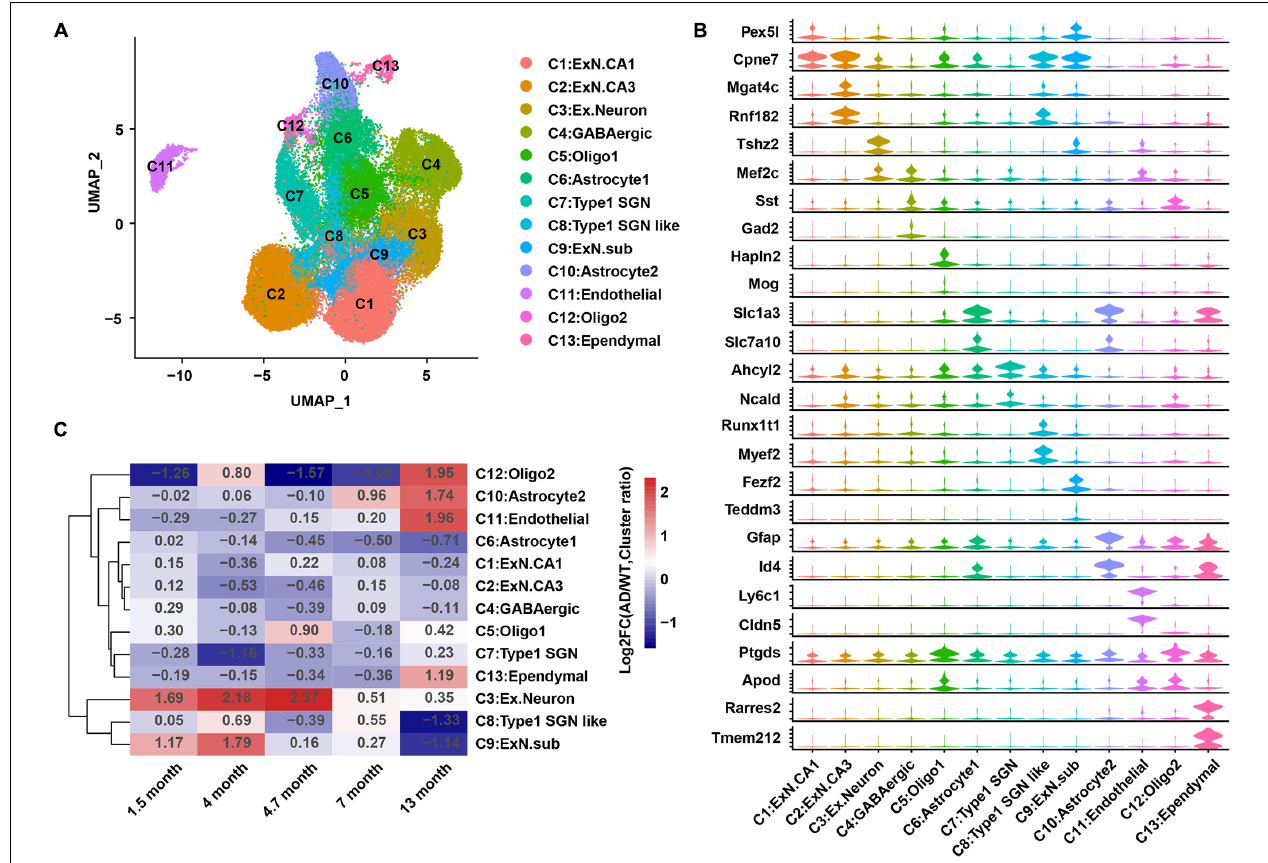
FIGURE 1 | A cell atlas of hippocampal cells in 5XFAD (AD) mice and WT mice. (A) Cell map of mouse hippocampus. Each dot represents a cell and is colored according to a cluster. (B) Violin plots showing the distribution of the expression of specific marker genes in each cell group. (C) Heatmap showing the changes in relative abundance of the 13 cell groups in AD mice compared to that in WT mice at 1.5, 4, 4.7, 7, and 13 months. AD, Alzheimer’s disease; WT,